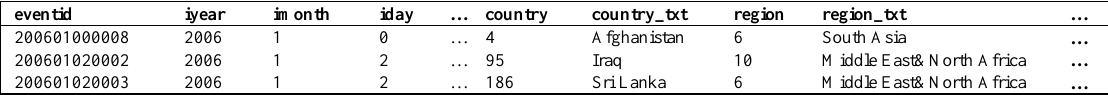
Table 1 Event data provided by GTD